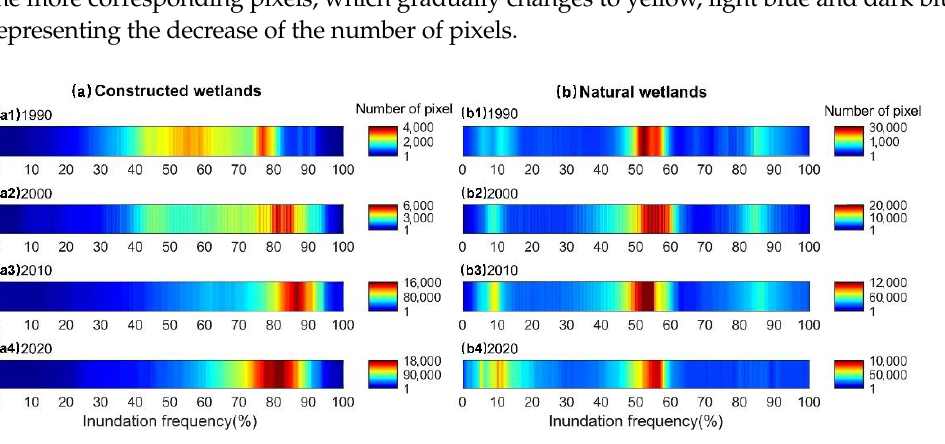
Figure 6. The inundation frequency distribution of wetlands in the YRD from 1999 to 2020, ( a ) con- structed wetlands and ( b ) natural wetlands.